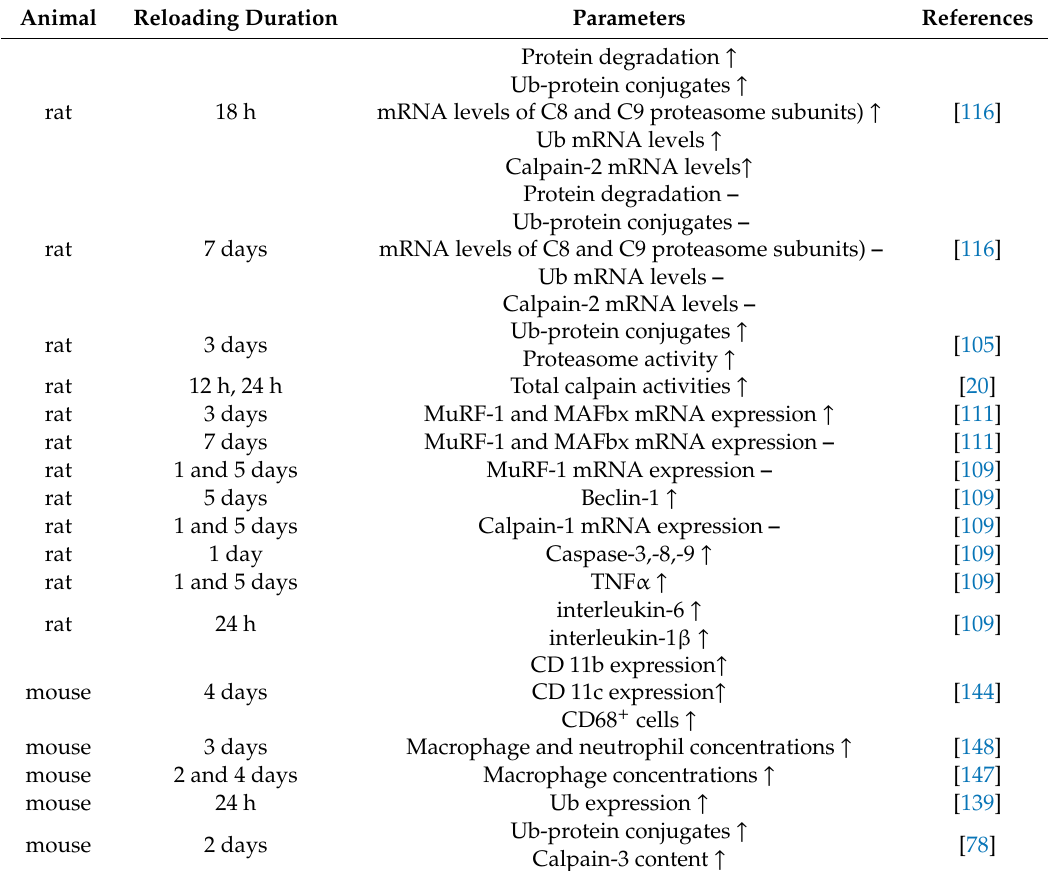
Table 2. The e ff ect of reloading after mechanical unloading on the markers of proteolysis and inflammation in rodent soleus